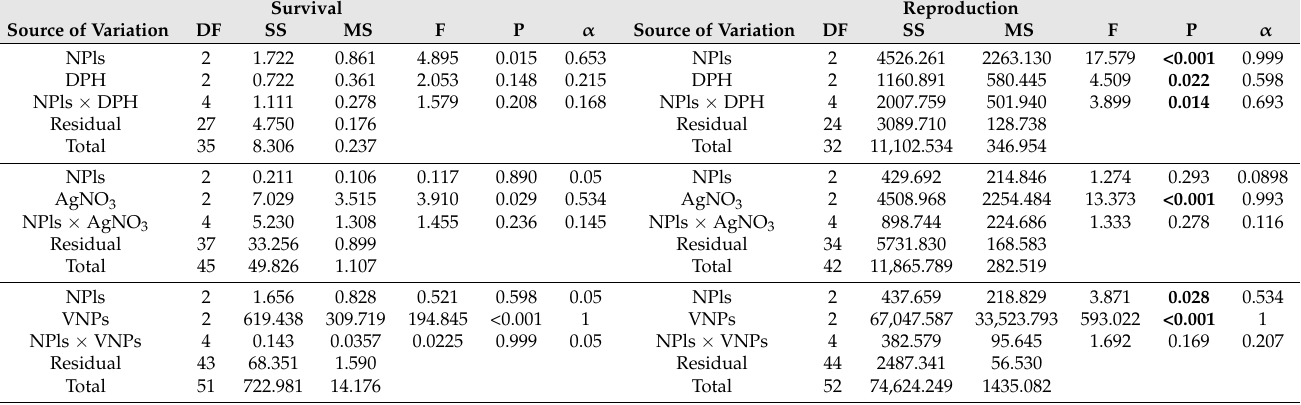
Table 2. Two-way ANOVA results for E. crypticus survival and reproduction after 28 days combined exposure to polystyrene nanoplastics (NPls) and diphenhydramine (DPH), silver nitrate (AgNO 3 ) or vanadium nanoparticles (VNPs) in LUFA 2.2 soil. Significant interactions ( p < 0.05) are highlighted in bold.